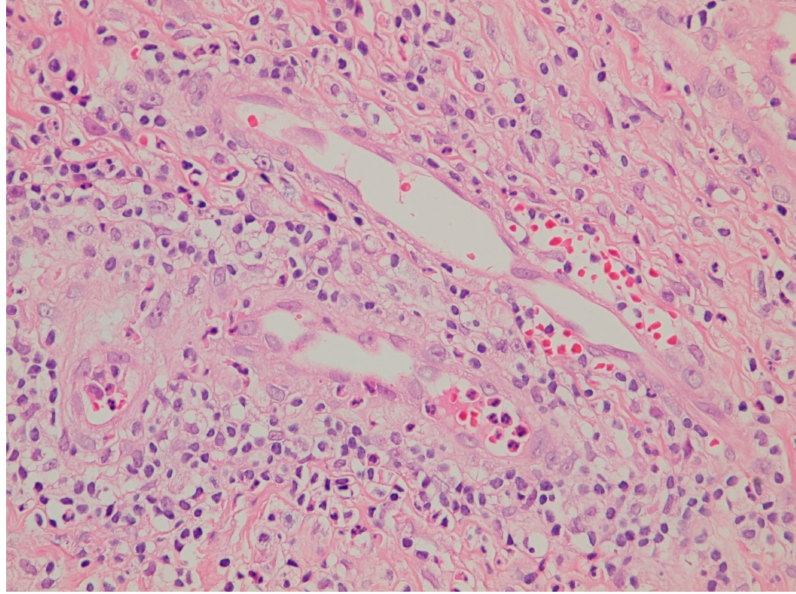
Figure 3. Dermal neurophilic infiltration with mixed inflammation and focal lymphocytic thrombogenic vaculopathy (hematoxylin and eosin stain, 500 ×